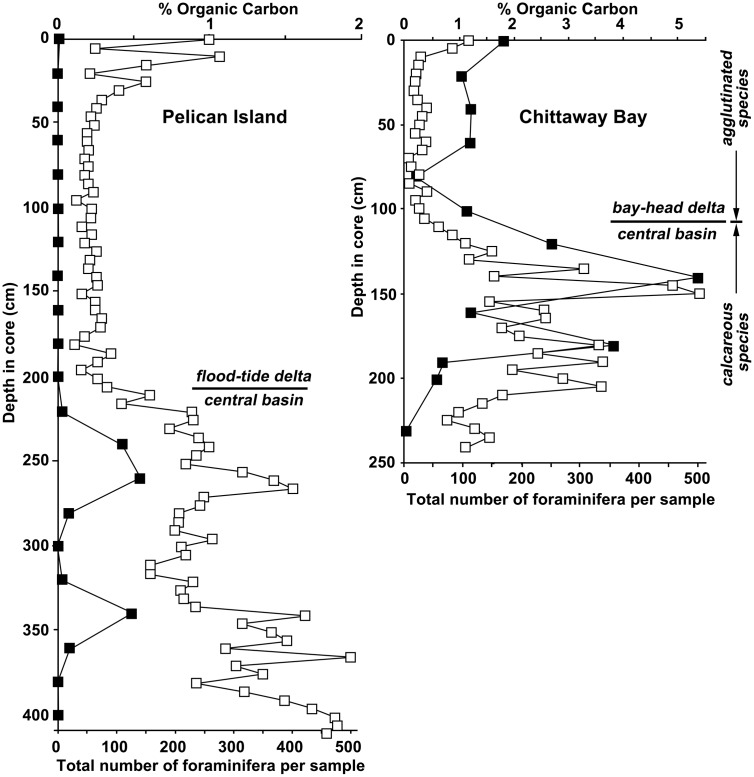
Downcore variation in foraminiferal abundance together with % organic carbon.